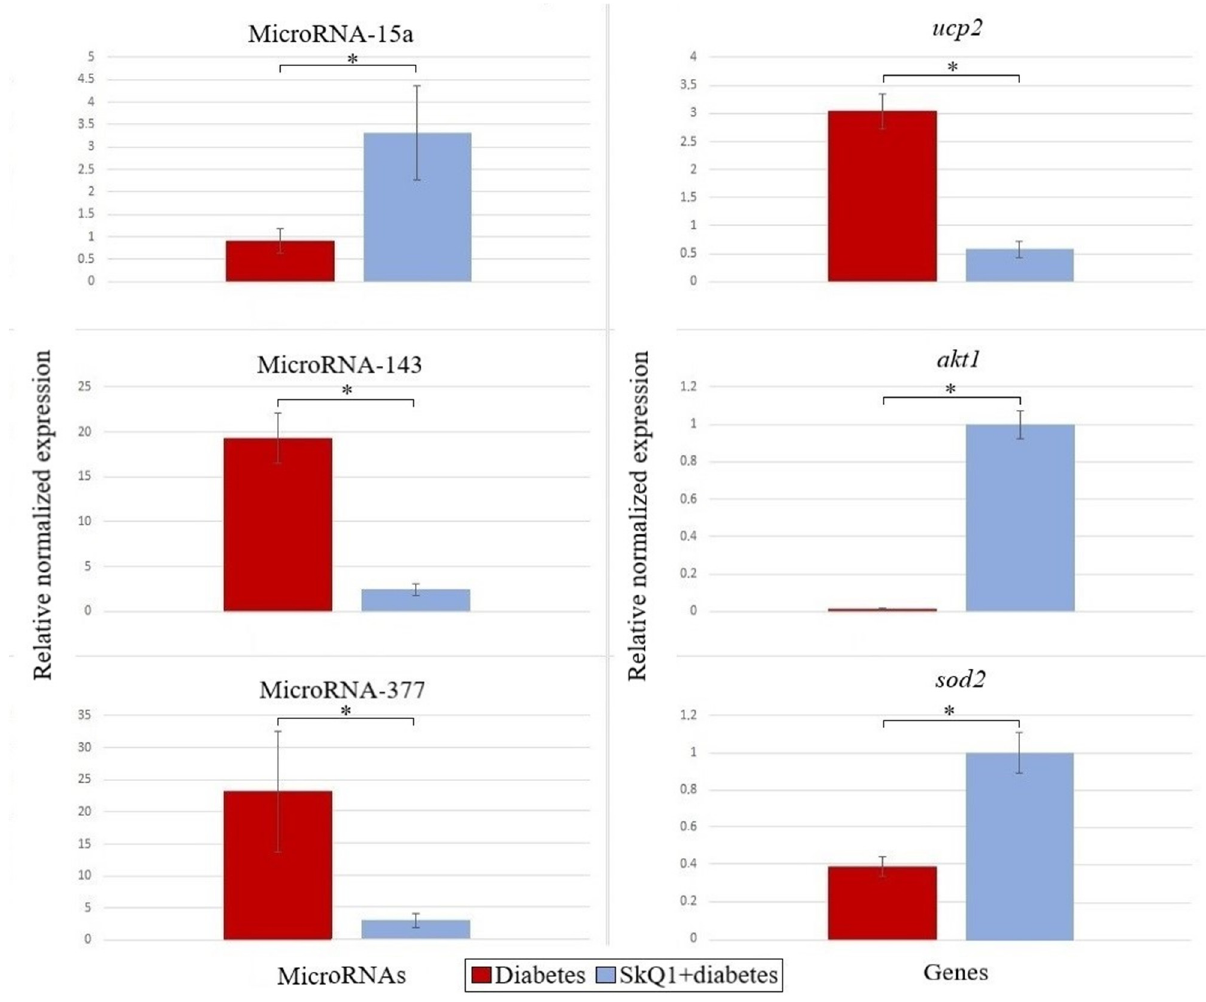
Figure 7. Effect of SkQ1 pre-therapy on the levels of various microRNAs and expression of their target genes (* p ≤ 0.05).